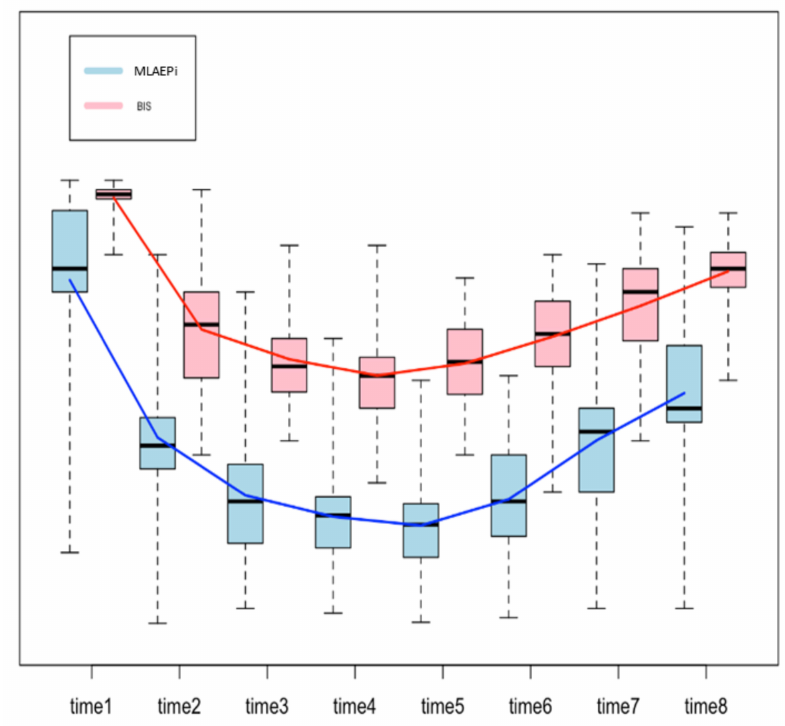
Figure 2. Boxplot to compare the Middle latency auditory evoked potential index (MLAEPi) and bispectral index (BIS). Since each method shows a range of the distinct means for each step, the comparison was performed on the differences between the means of the contiguous steps of analysis (e.g., procedure start mean–loss of consciousness, mean = 33.81) by using a two-sample t-test. The procedure was based on eight steps, and so there were seven